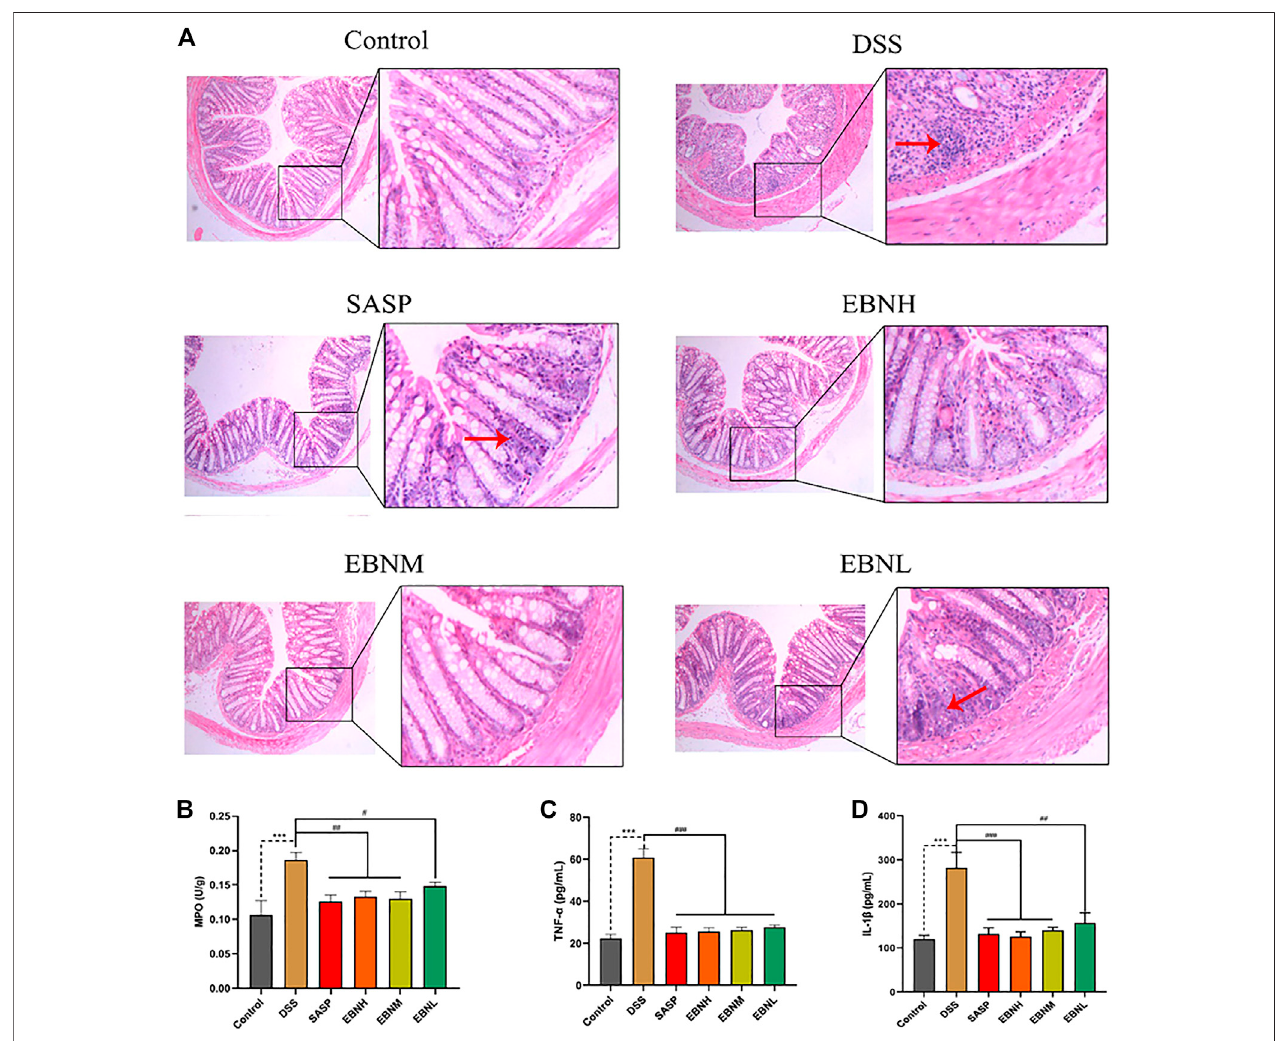
FIGURE 3 | Effects of EBN pretreatment on in fl ammation in DSS-induced UC. (A) Effect of EBN on colonic histomorphology in mice with colitis induced by DSS (50 × ). (B – D) EffectsofEBNonMPOactivityandTNF- α andIL-1 β levelsincolonictissuesofmicewithcolitisinducedbyDSS.** P < 0.01and*** P < 0.001comparedwith the control group, # P < 0.05 and ## P < 0.01 compared to the DSS group ( x ± S , n (cid:2) 6).